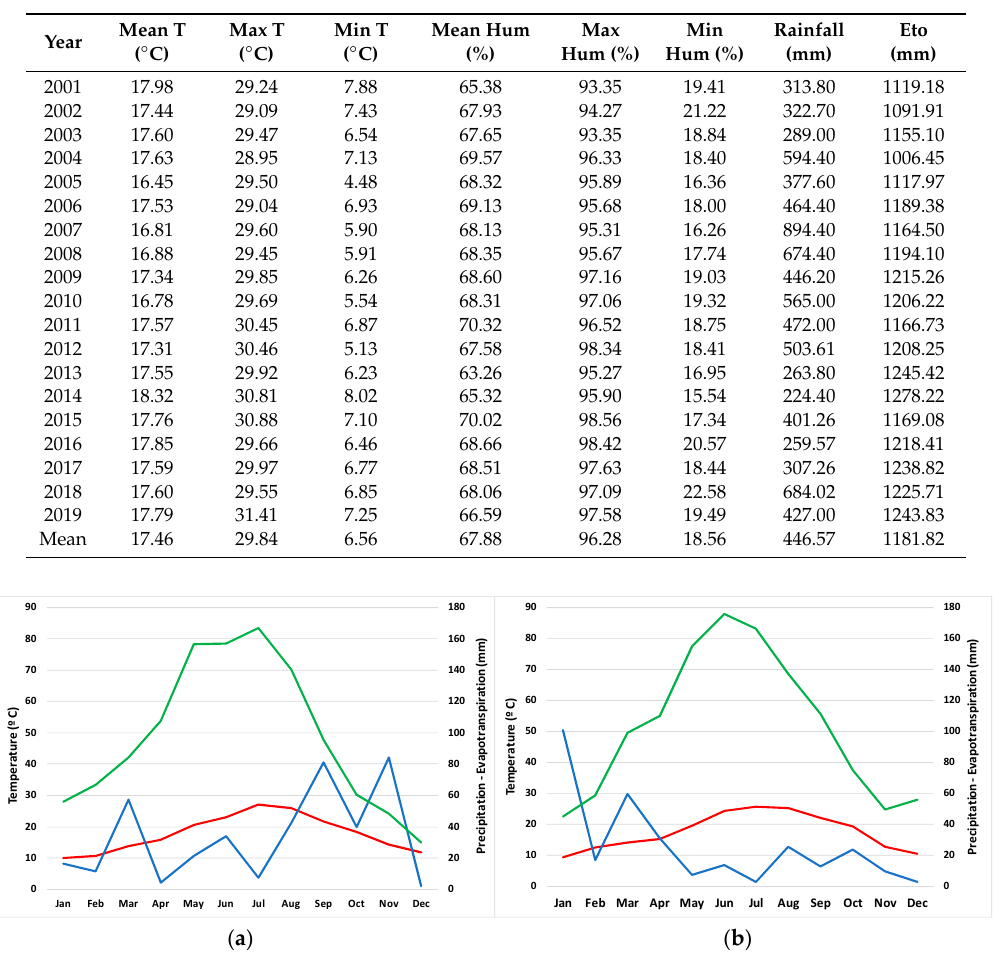
Table 3. Meteorological data for the last 19 years obtained from the agroclimatological station Benifaio; data provided by the Agroclimatic Information System for Irrigation (SIAR) [24]. T: temperature; Hum: humidity; Eto: evapotranspiration.